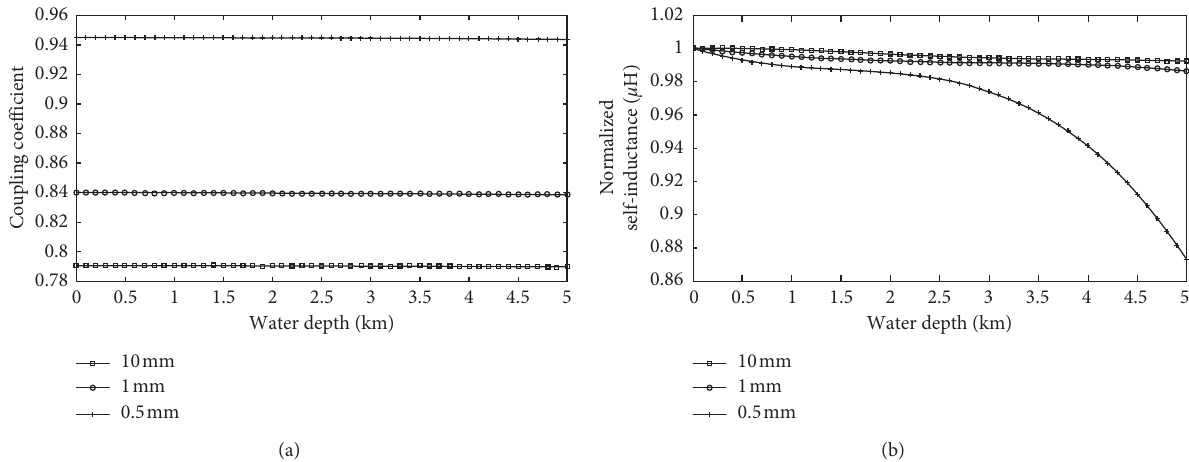
Figure 4: Simulation results of coil self-inductance and mutual inductance. (a) Coupling coefficient with water depth. (b) Self-induction with water